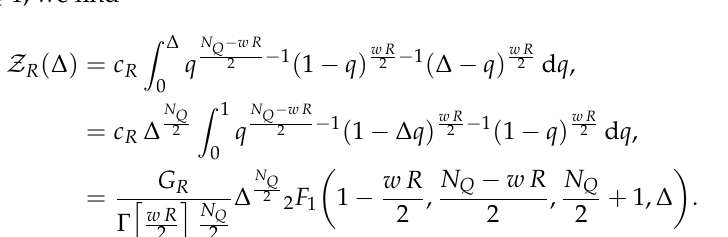
Γ [ wR ] N Q 2 is 2 G R